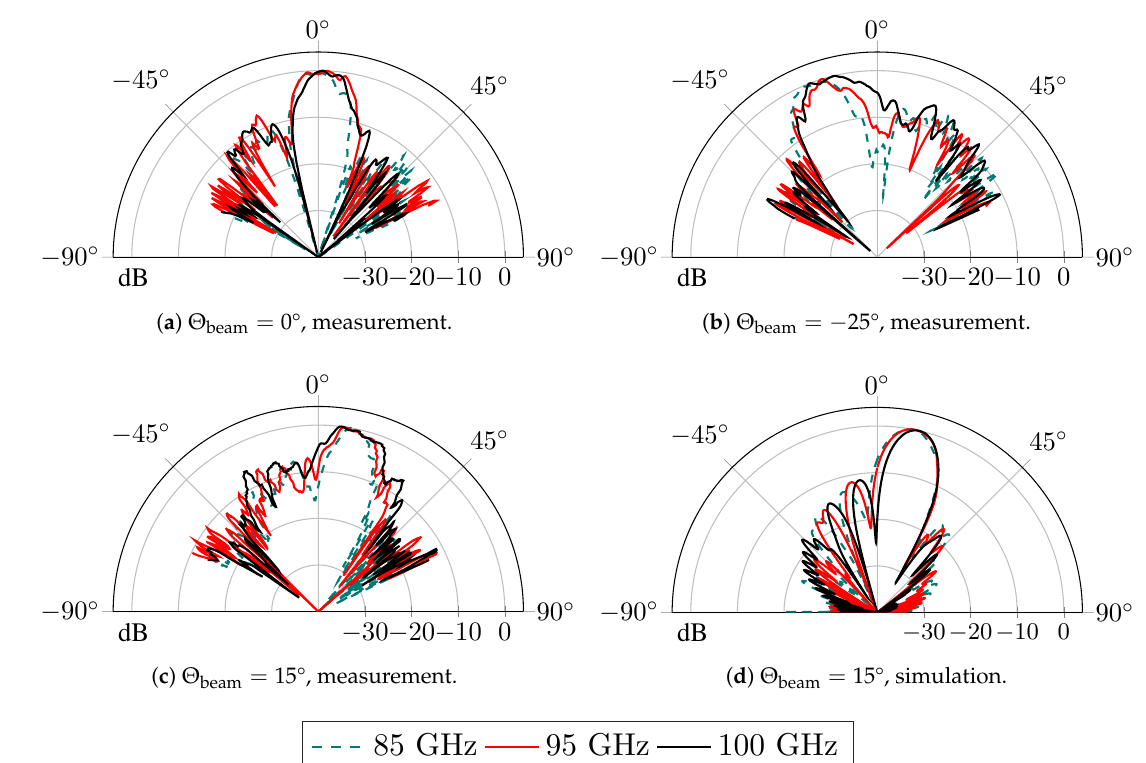
Figure 32. Pattern at three different frequencies, ( a , b ) are measured results, while ( c , d ) serves as a reference to the simulations.